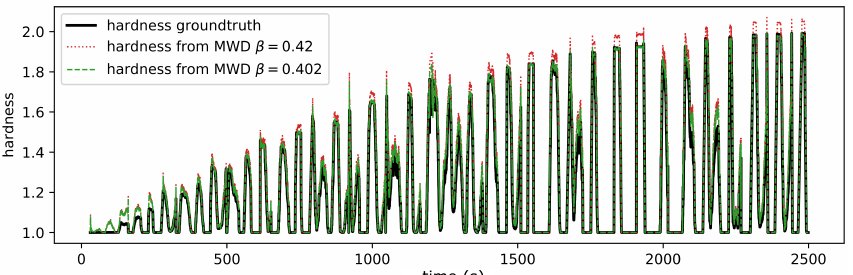
Figure 12. The true and predicted hardness given the MWD signal with the presence of a 12.5 m tracking error. In addition to the best fit model ( β = 0.402), a slightly erroneous fitted model ( β = 0.42) is included.